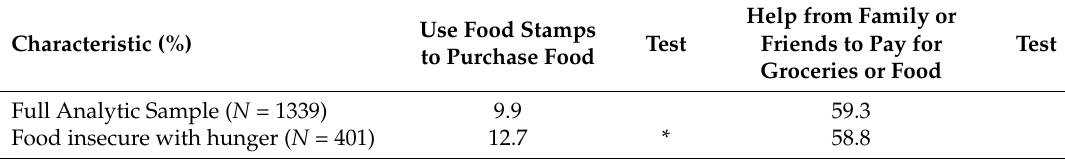
Table 5. Variation in supports among students who are food insecure with